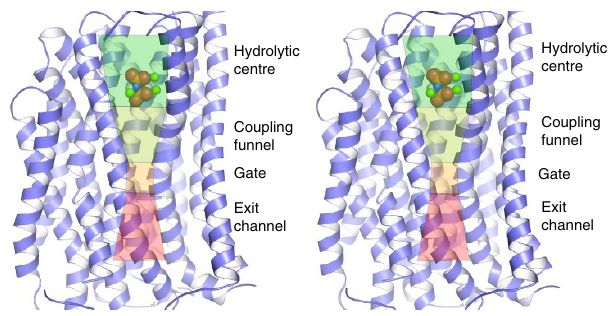
Figure 1 | Stereo view of the vertical channel composition of M-PPases. Structural overview of an M-PPase:IDP complex, showing the various sub-structures in the active site: the hydrolytic centre, coupling funnel, ion gate and exit channel. Helices 5, 9, 10 and 15 have been removed for